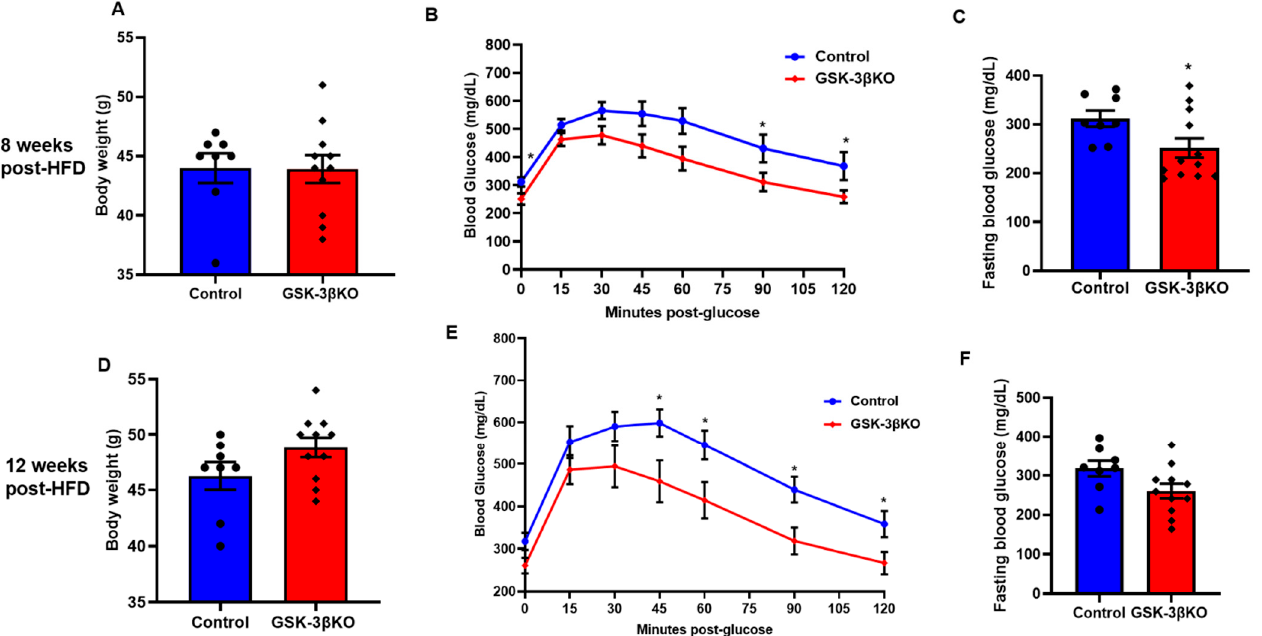
Figure 4. Conditional global GSK-3 β deletion protects GSK-3 β KO mice from HFD-induced glucose intolerance. GSK-3 β KO and control animals were subjected to an HFD and were analyzed at 8 and 12 weeks post-HFD. Compared to the controls, GSK-3 β KO mice exhibited improved glucose clearance at both timepoints. ( A ) Body weight, ( B ) glucose tolerance test, and ( C ) fasting blood glucose in GSK-3 β KO and control animals after 8 weeks on an HFD. ( D ) Body weight, ( E ) glucose tolerance test (GTT), and ( F ) fasting blood glucose in controls and KO animals after 12 weeks on an HFD; * p < 0.05 WT vs. KO.